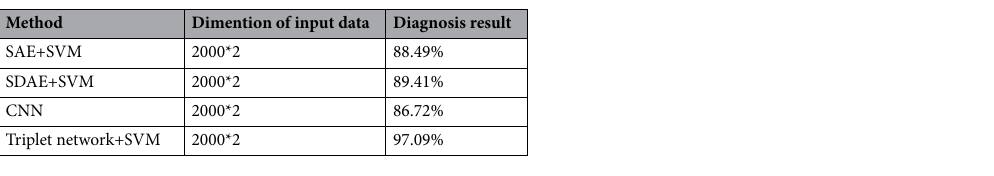
Table 5. Diagnosis result of each